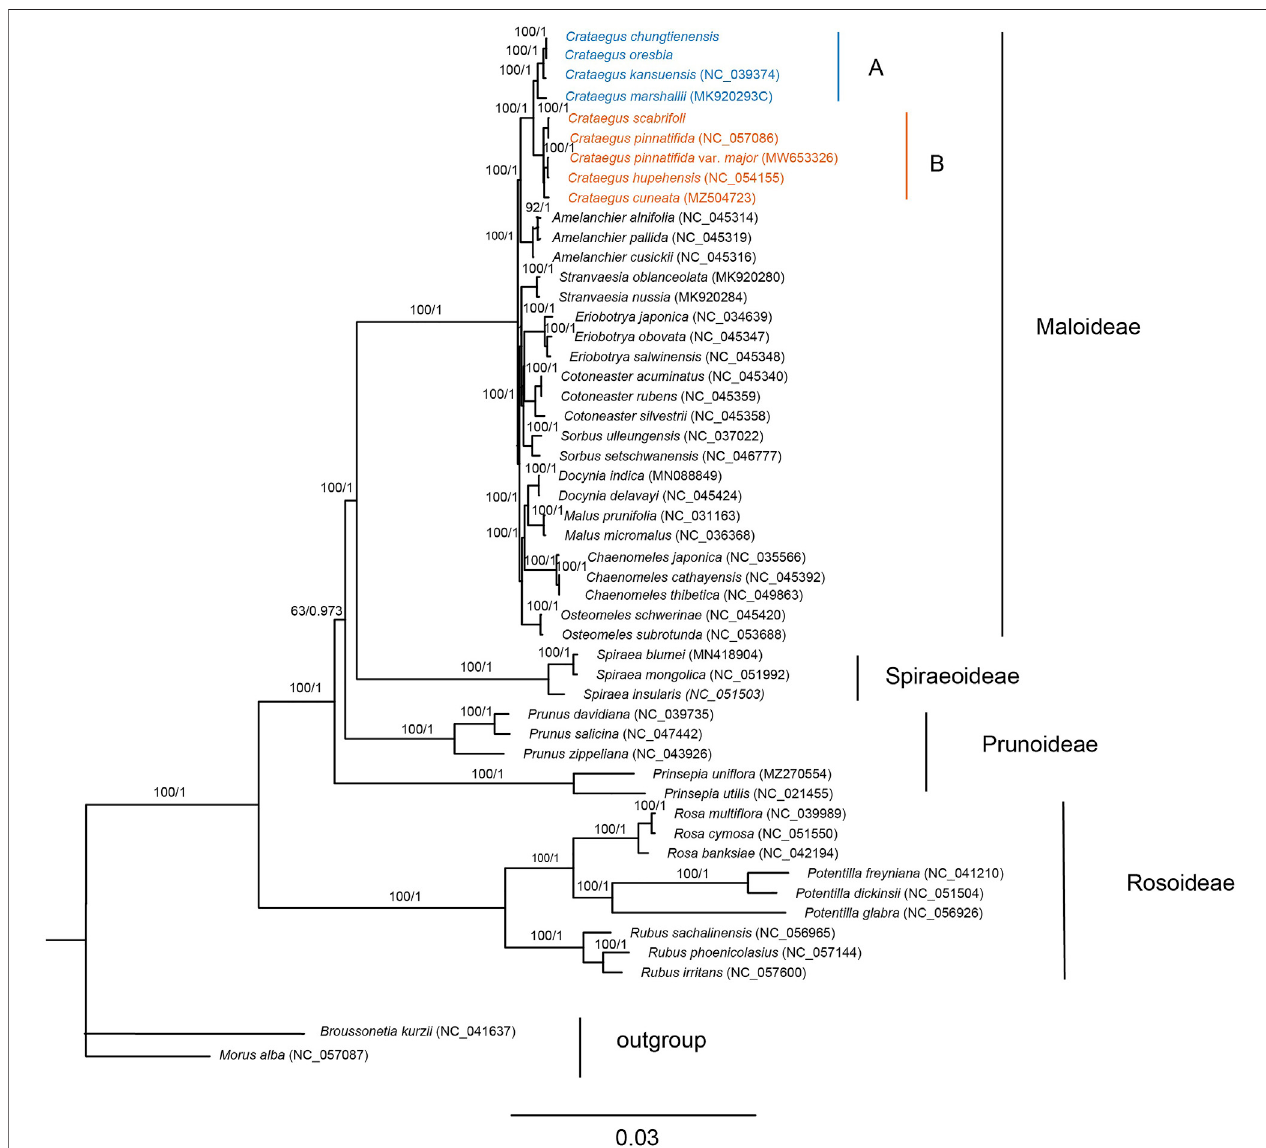
FIGURE 6 | Phylogenetic tree of Crataegus within the Rosaceae. The entire genome data set was analyzed using maximum likelihood (ML) and Bayesian information (BI). Different colors represent different clades (A,B) .